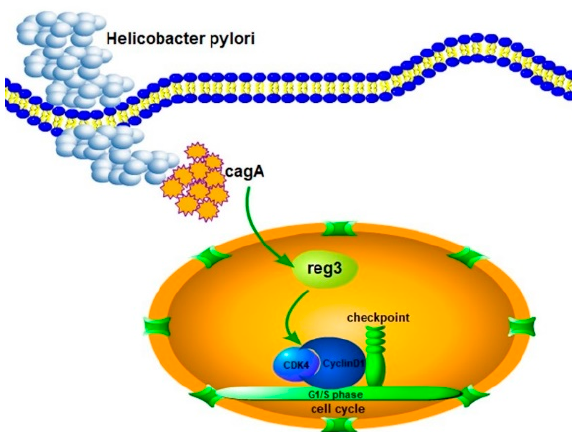
Figure 7. reg3 regulates cell cycle after CagA-positive H. pylori infection.